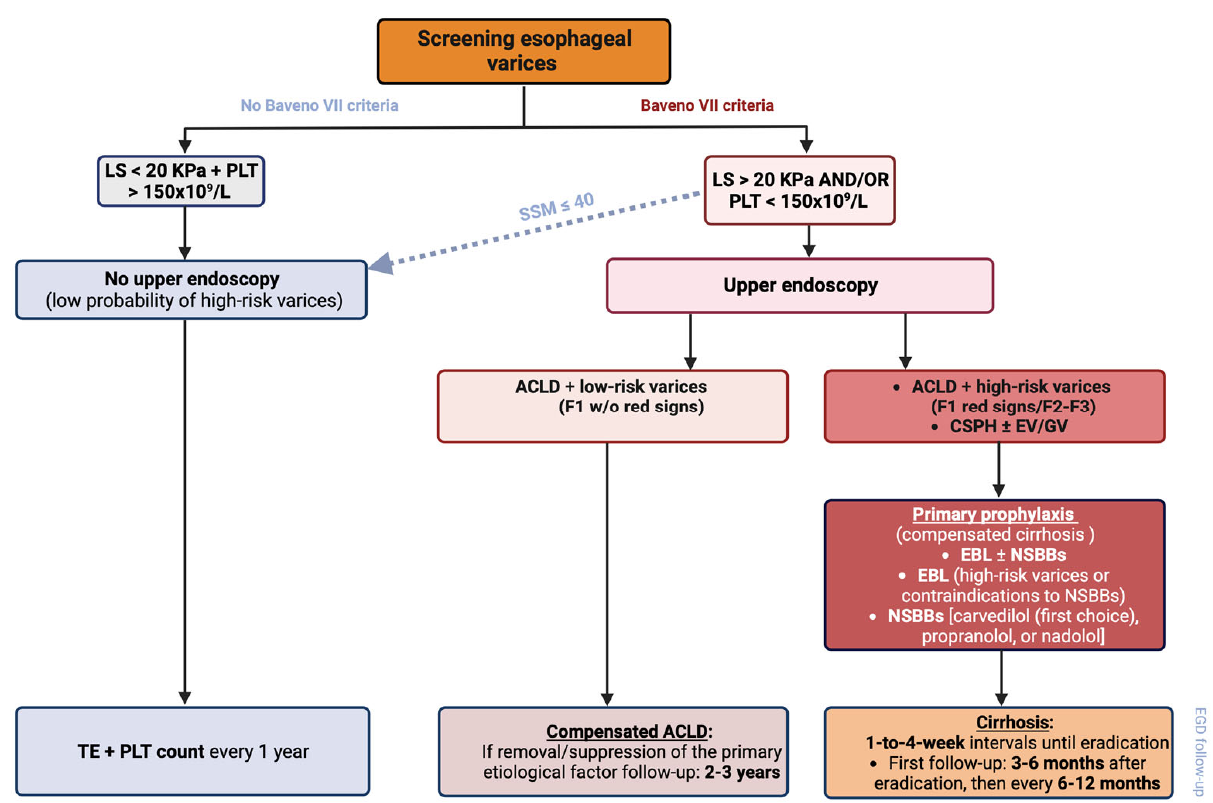
Figure 3. Screening and primary prophylaxis of esophageal varices.